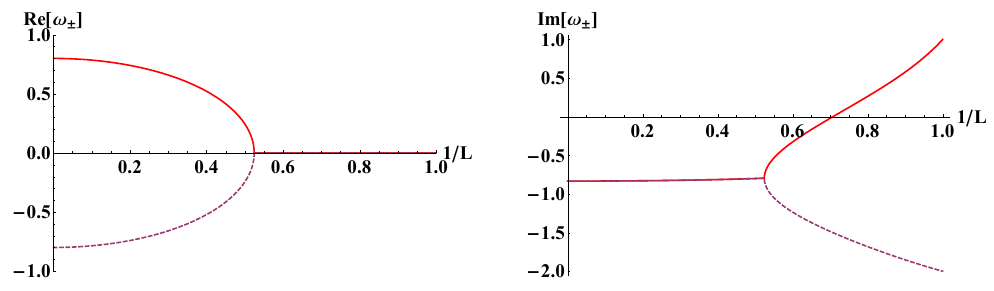
Figure 1 . The quasinormal mode frequencies ! + (solid line) and ! (cid:0) (dashed line) of the gravita- tional perturbation of de Sitter Gauss-Bonnet black hole with ‘ = 2 and (cid:11) = 1. The real part and the imaginary part are depicted in the left and right panel respectively. When 1 =L > 1 = the perturbation becomes unstable.